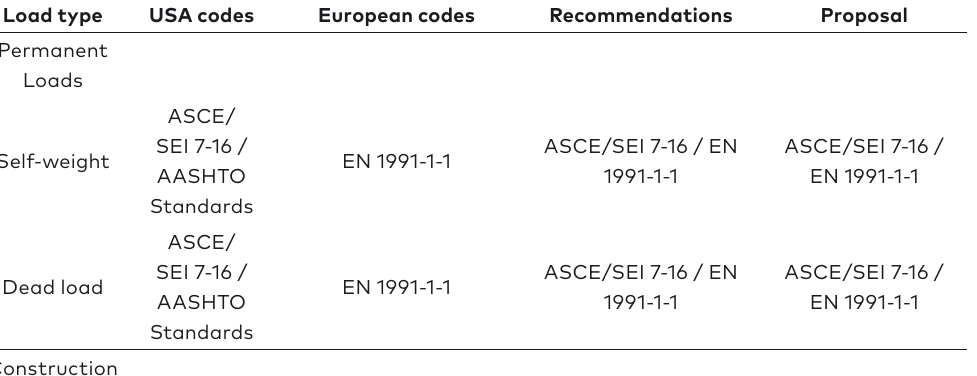
Table 1. Summary of design loads by code provisions,